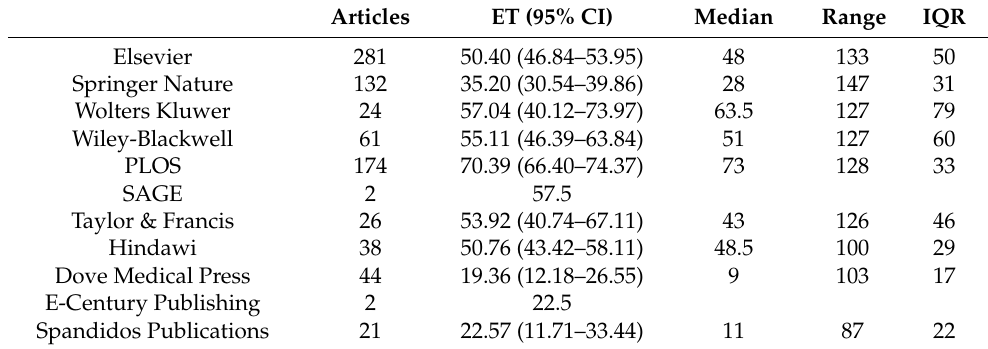
Table 9. Image retractions by